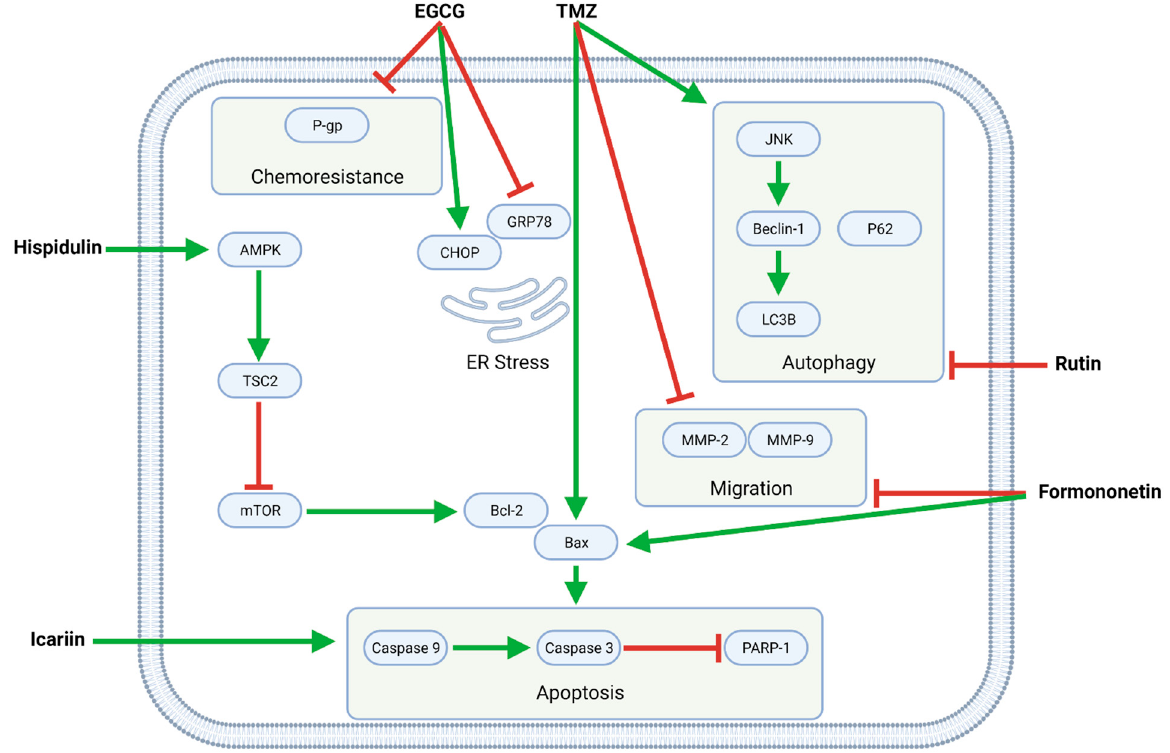
Figure 4. The flavonoids EGCG, formononetin, hispidulin, icariin, and rutin exert pleiotropic anti-GBM effects combined with TMZ. Formononetin, hispidulin, and icariin synergistically enhance TMZ-mediated apoptosis by increasing the Bax/Bcl-2 ratio and activating caspases; formononetin additionally potentiates TMZ’s anti-migratory effects. Moreover, EGCG downregulates P-gp, thereby increasing the sensitivity of (otherwise resistant) GBM cells to TMZ. Finally, rutin inhibits TMZ-induced autophagy and, as such, promotes apoptotic cell death. Table 3. Mechanistic anti-GBM effects of flavonoid-TMZ combinations, as demonstrated in vitro and in vivo.